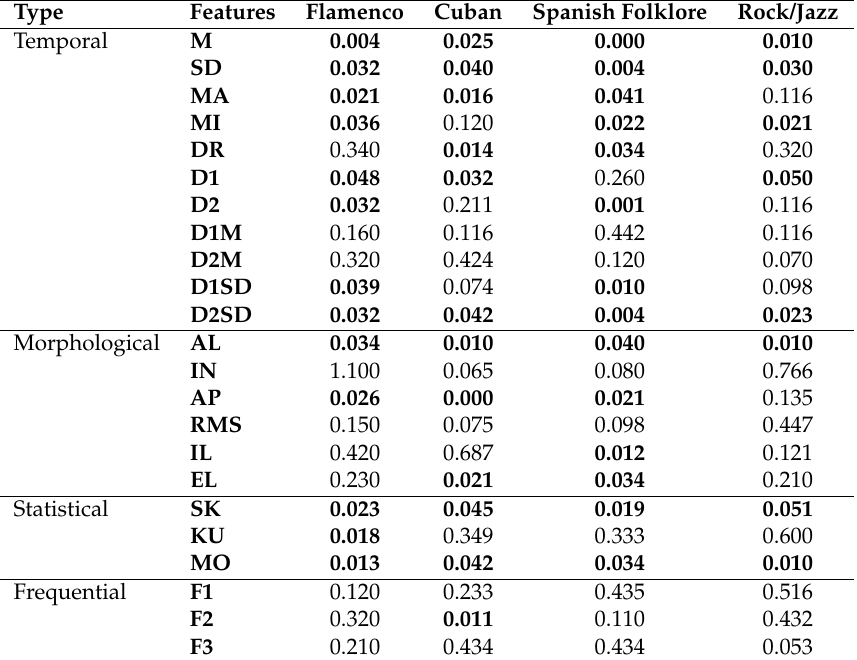
Table 4. p -value for the different features.